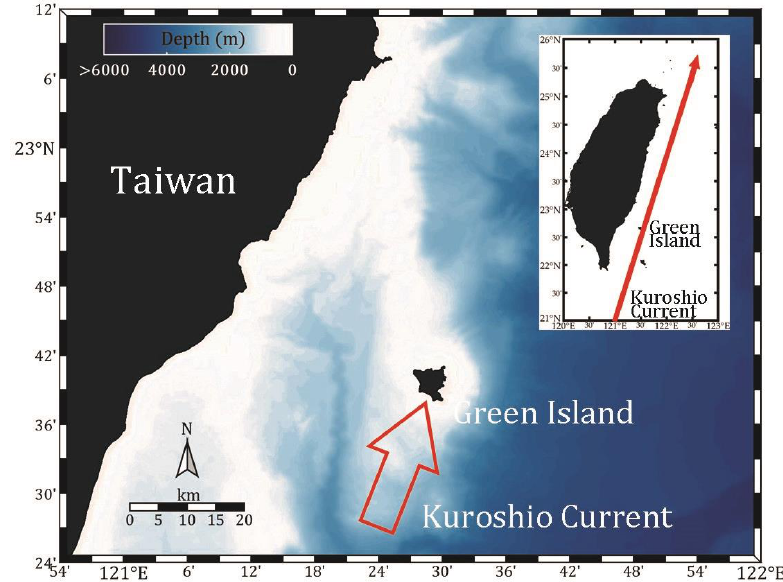
Figure 1. The bottom topography around Green Island and the path of the Kuroshio (red line and arrow).